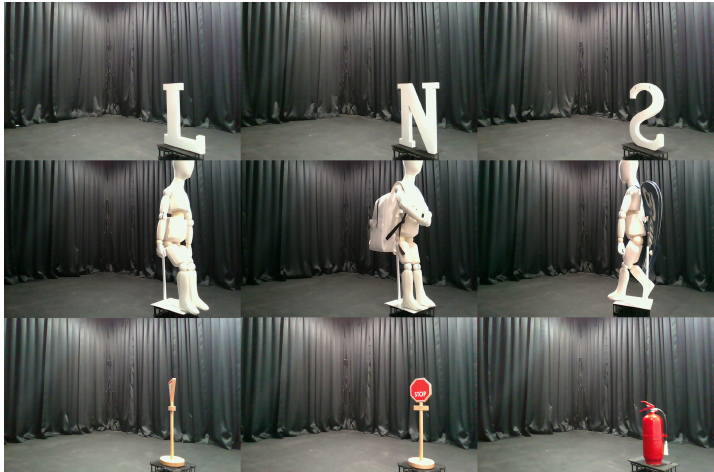
Figure 3. Examples of objects used for data collection.